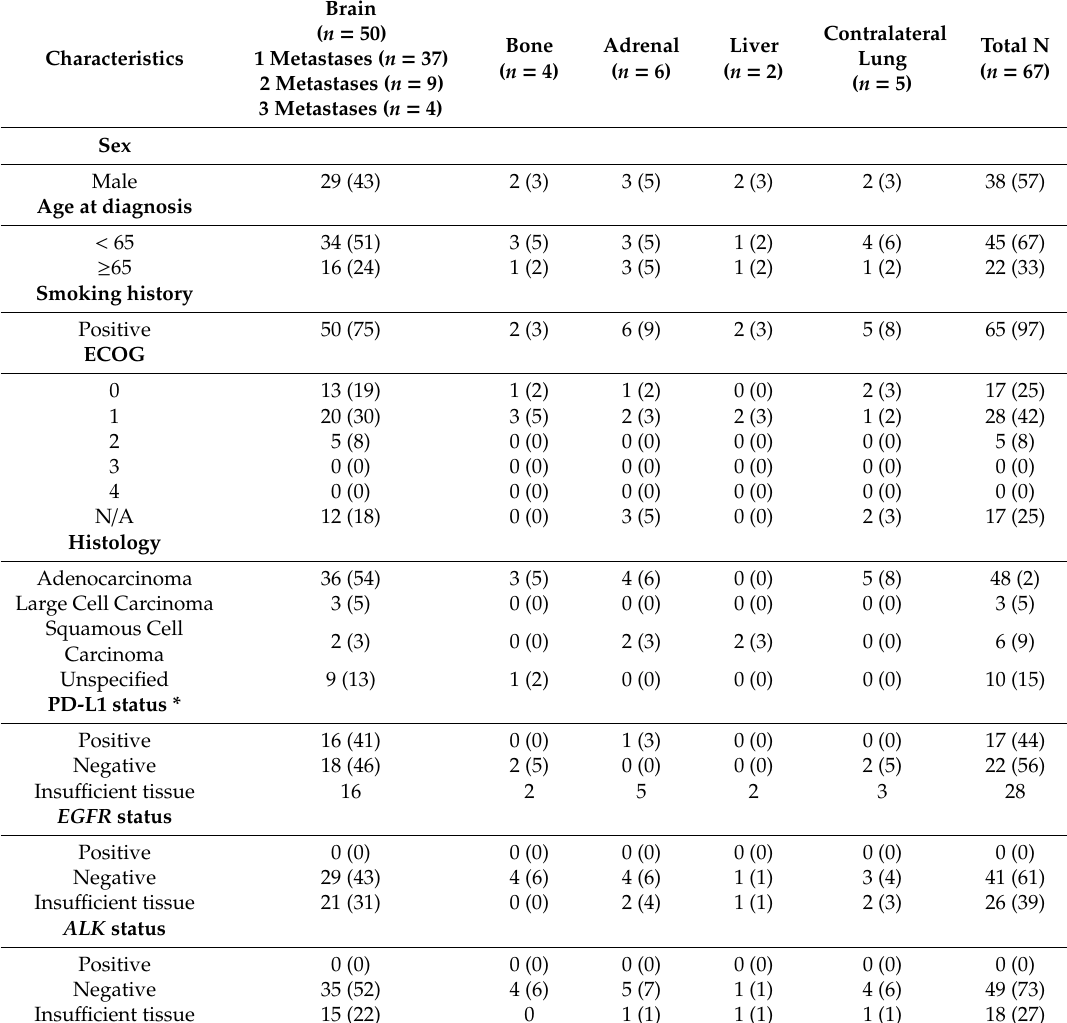
Table 1. Demographic and disease characteristics of